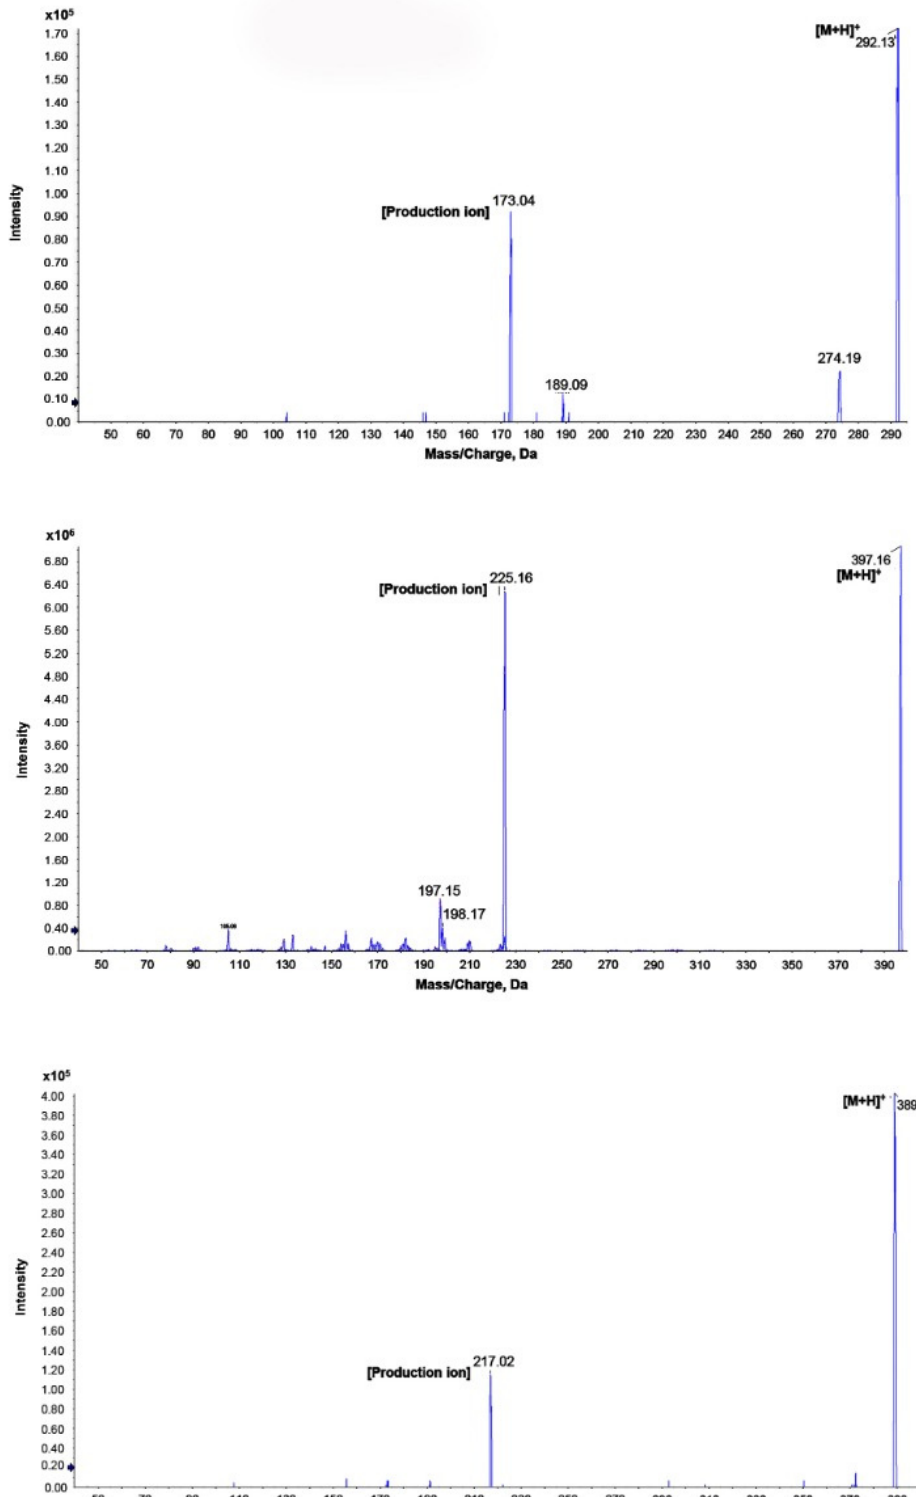
Figure 4. Representative mass spectra for AW-9a, WES-1, and WES-2 by the proposed liquid chromatography (LC)-MS / MS